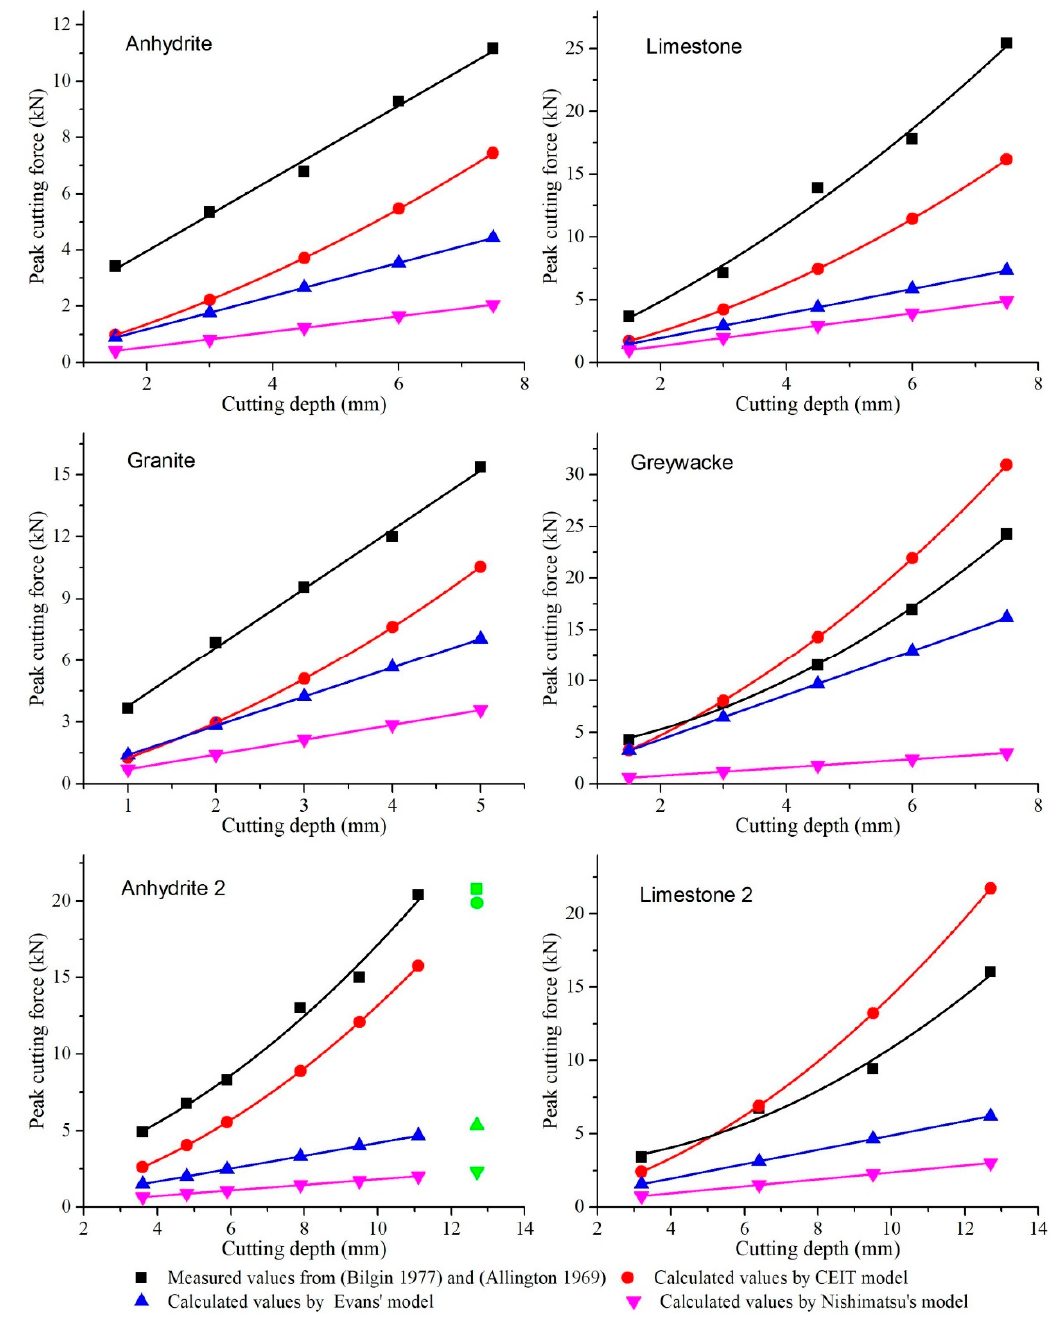
Figure 9. Comparison of the calculated and measured peak cutting forces at different cutting depths.